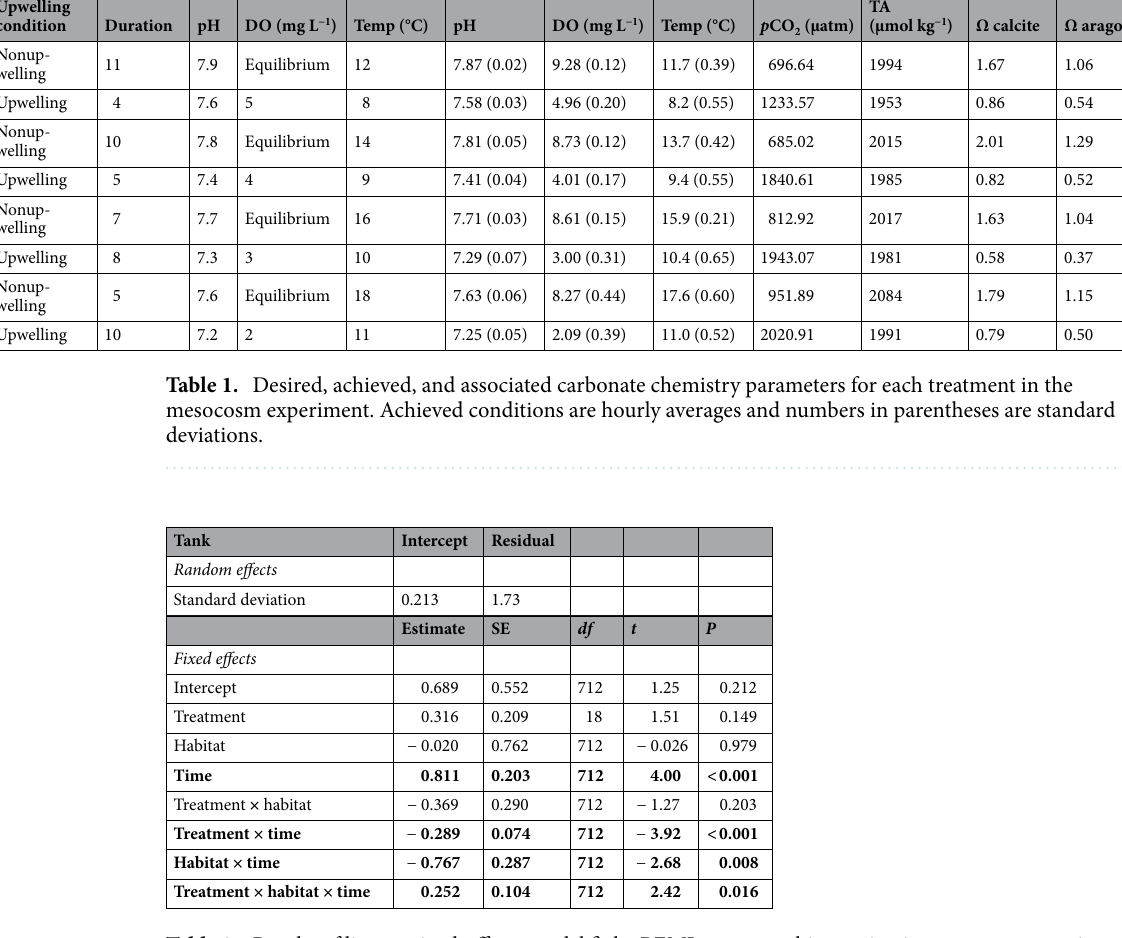
Table 2. Results of linear mixed-effects model fit by REML on sea urchin grazing in mesocosm experiment. Bold text indicates statistical significance at α =